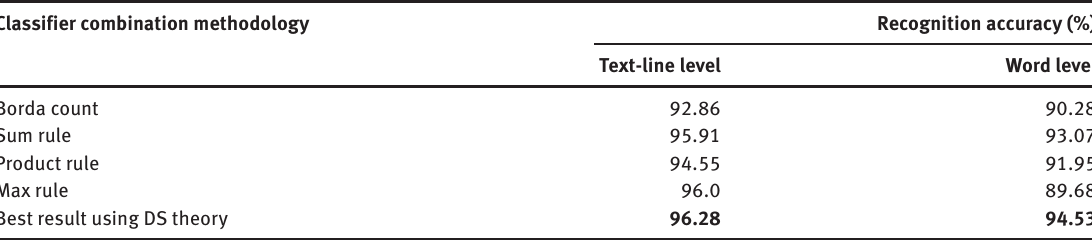
Table 4: Performance Comparison of the Present Classifier Combination Technique with Other Combination Techniques at Both Text-Line and Word Levels (Bold Style Shows the Best Case).